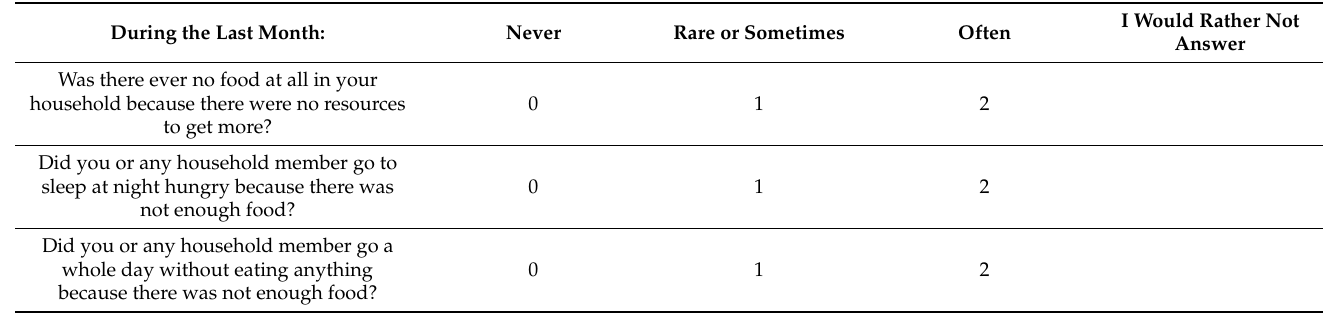
Table A2. The 3-item household food insecurity